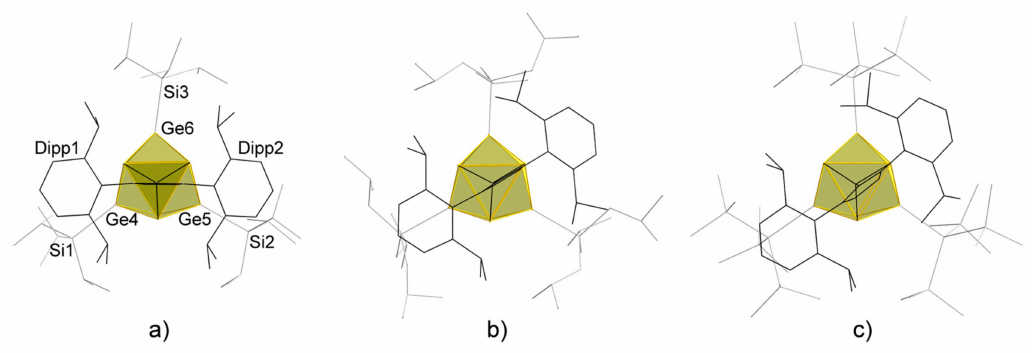
Figure 3. Top views of NHC Dipp Cu{ η 3 -Ge 9 R 3 }. The silyl groups connected to the cluster are shown as grey wire frames. ( a ) R = Si( i Pr) 3 , 1 ; ( b ) R = Si( i Bu) 3 [19] and ( c ) R = Si(TMS) 3